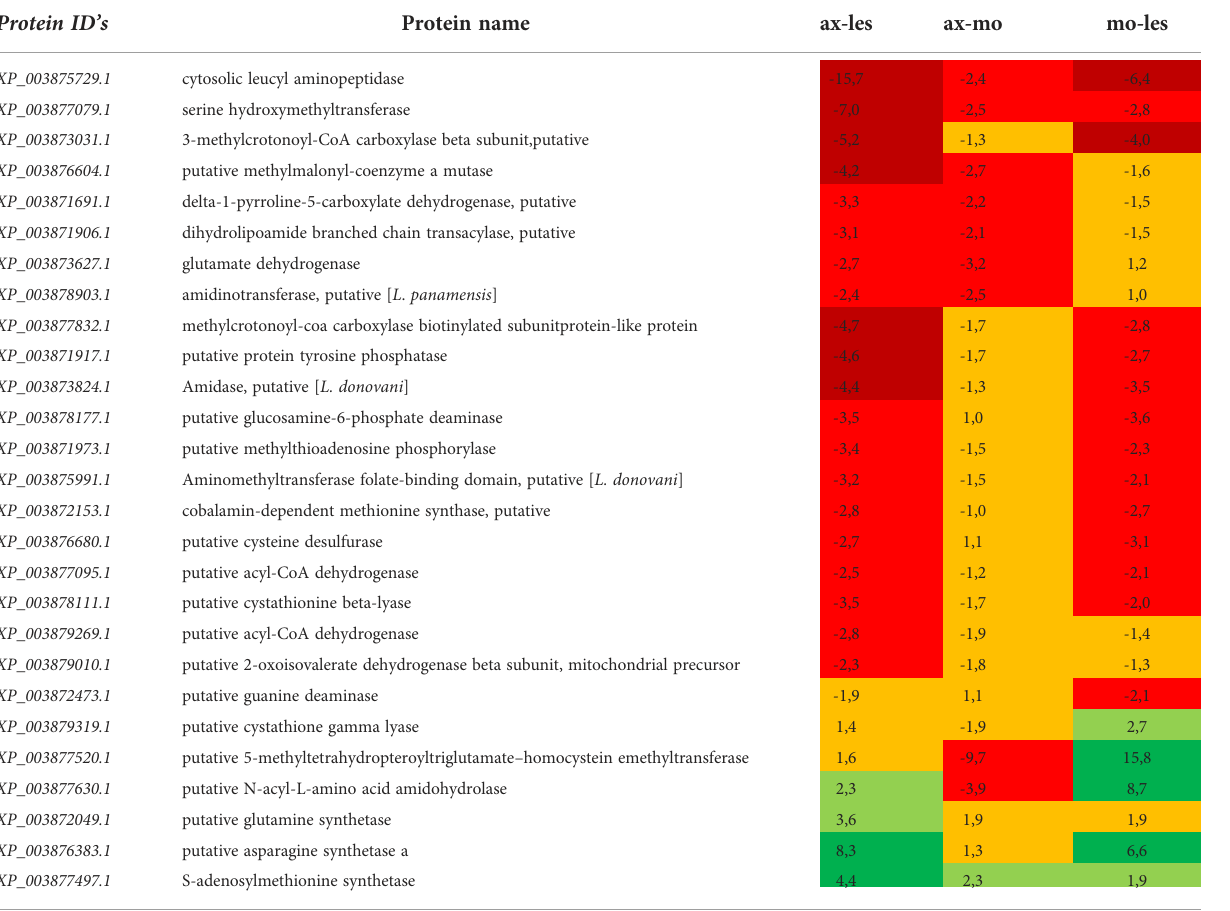
TABLE 5 Amino acid metabolism enzymes identi fi ed in all 3 comparisons that differ by at least 2-fold (T-test signi fi cant) between individual amastigote types. Amino acid metabolism